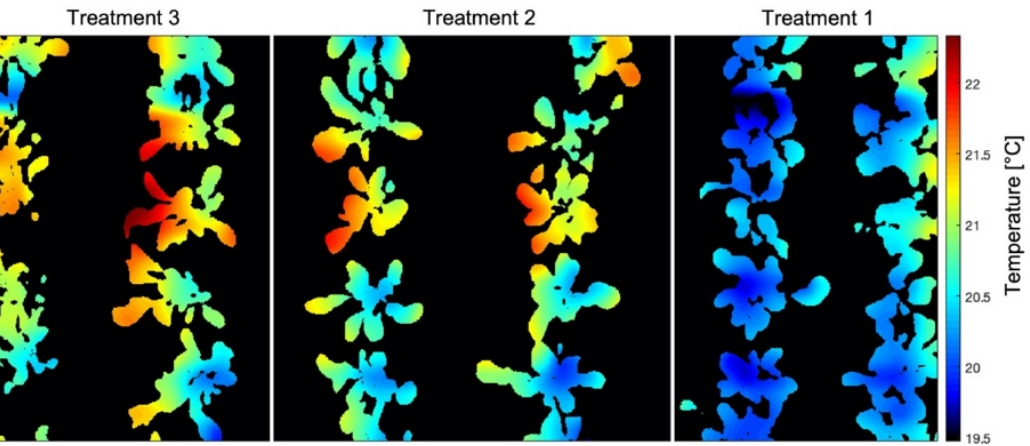
Figure 4. Leaf Temperature Map generated by crossing the temperature map of the experimental area with the segmented image of the crop—25DAP (Day After Planting). Treatment 1 (T 1 = 85% FC (Field Capacity)); Treatment 2 (T 2 = 75% FC); Treatment 3 (T 3 = 55% FC).